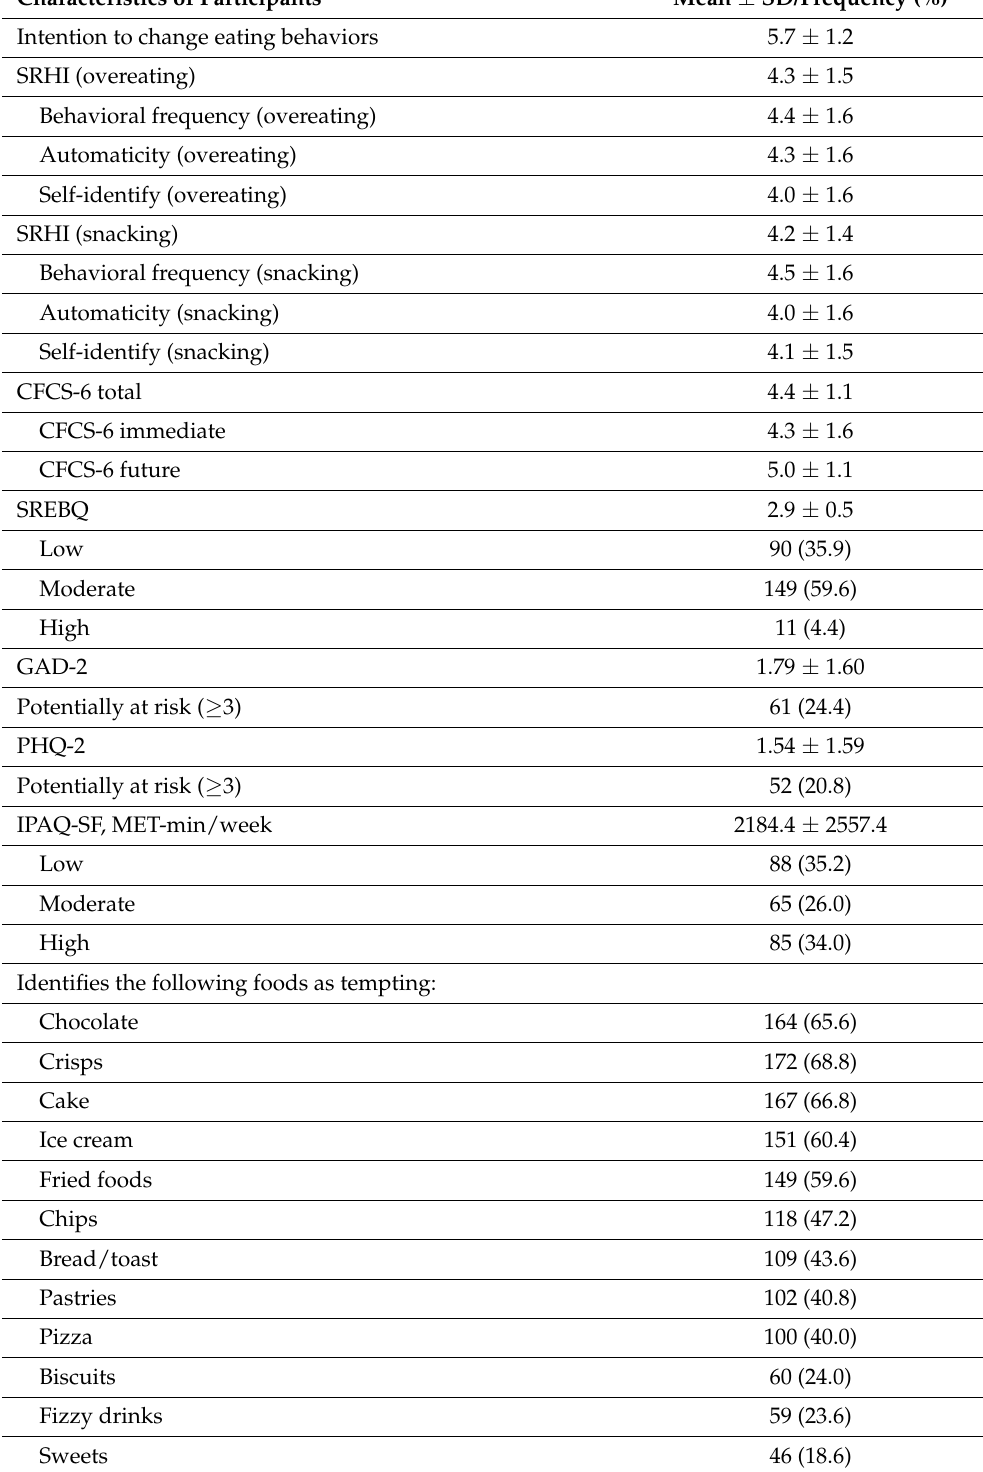
Table 2. Mean scores of the 250 study participants on each psychological and physical variable. Characteristics of